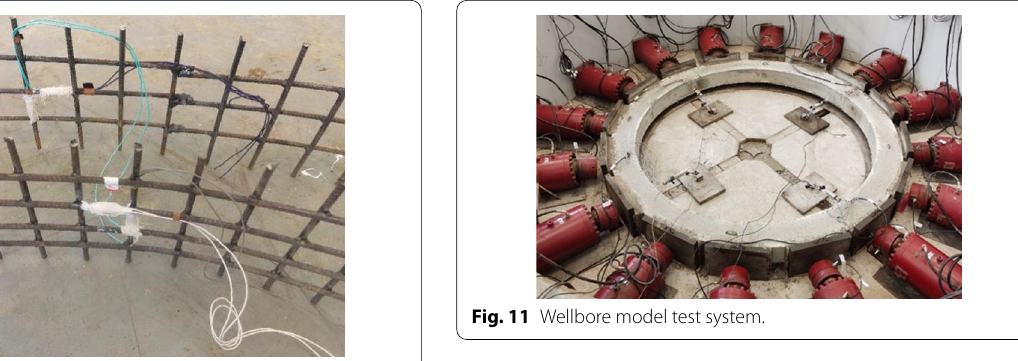
Fig. 9 Strain gauges installed on the steel cage.